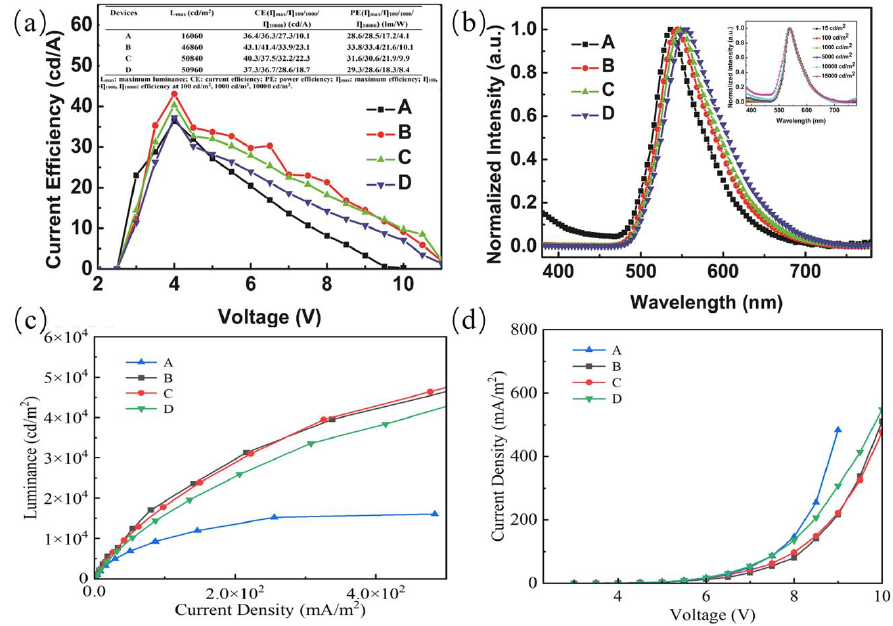
Figure 2. Current efficiency – voltage ( a ), normalized EL spectra at the voltage of 9 V ( b ), luminance – current density ( c ) and current density – voltage ( d ) characteristics of the devices A-D. The inset in Figure 2b shows the normalized EL spectra of the device A at different luminance.